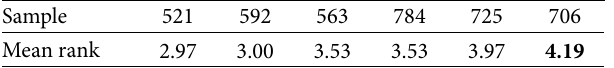
Table 6: Friedman test ranks.